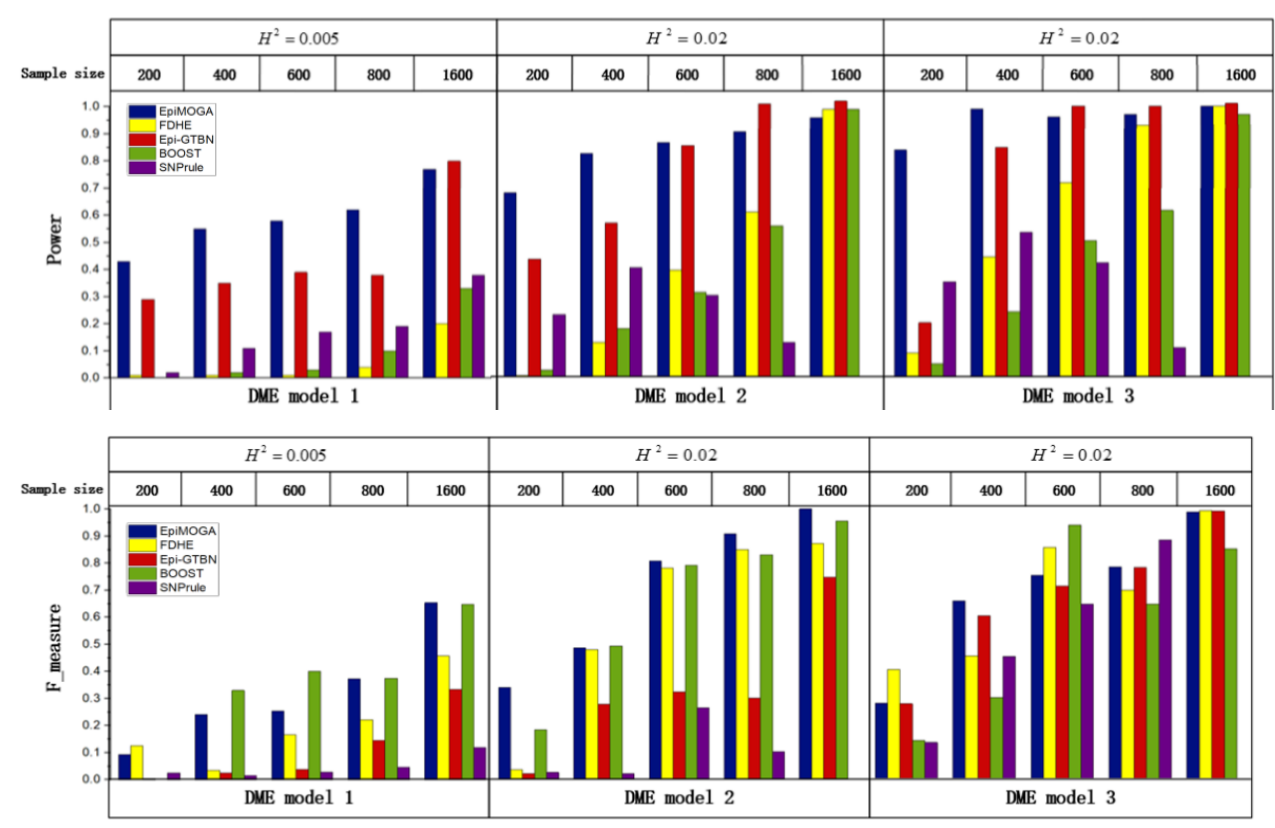
Figure 2. Detection efficiency and accuracy comparisons between EpiMOGA and other methods on 3 DME models.